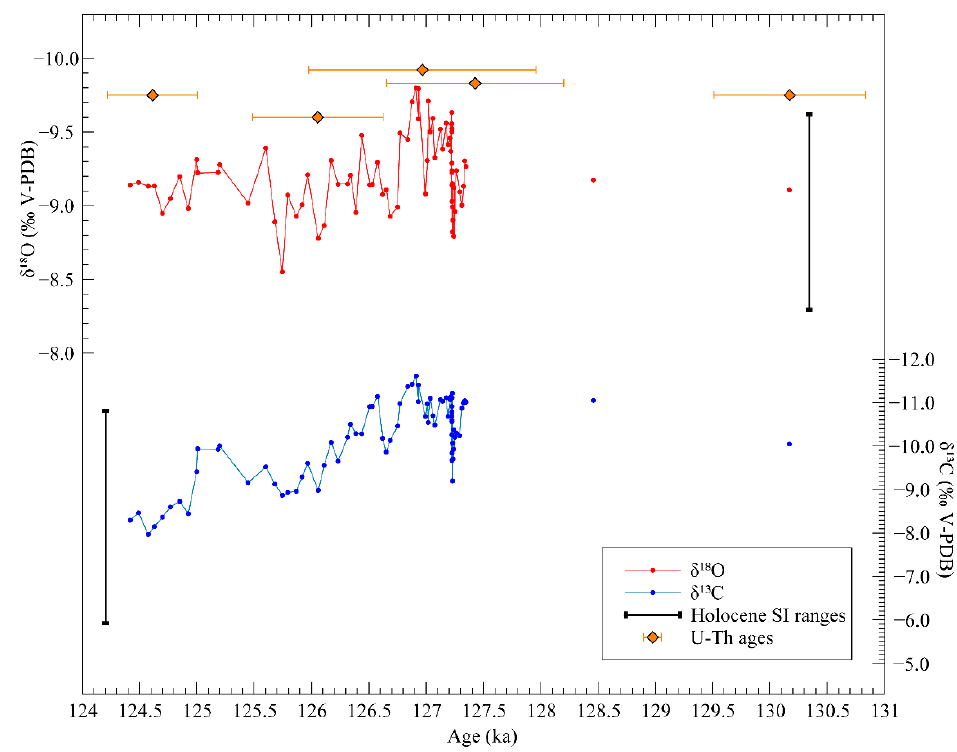
Figure 4. δ 13 C and δ 18 O from Kf-21 together with U-Th ages with error bars. Black vertical bars show the range of δ 13 C and δ 18 O in early- to mid-Holocene stalagmite K1 from Korallgrottan [14]. There is a positive correlation between δ 13 C and δ 18 O along the growth axis (r = 0.63; n = 79; P < 0.001). There is no distinct shift in isotope values between the upper and lower parts of the speleothem, and overlapping samples from the respective areas yielded similar